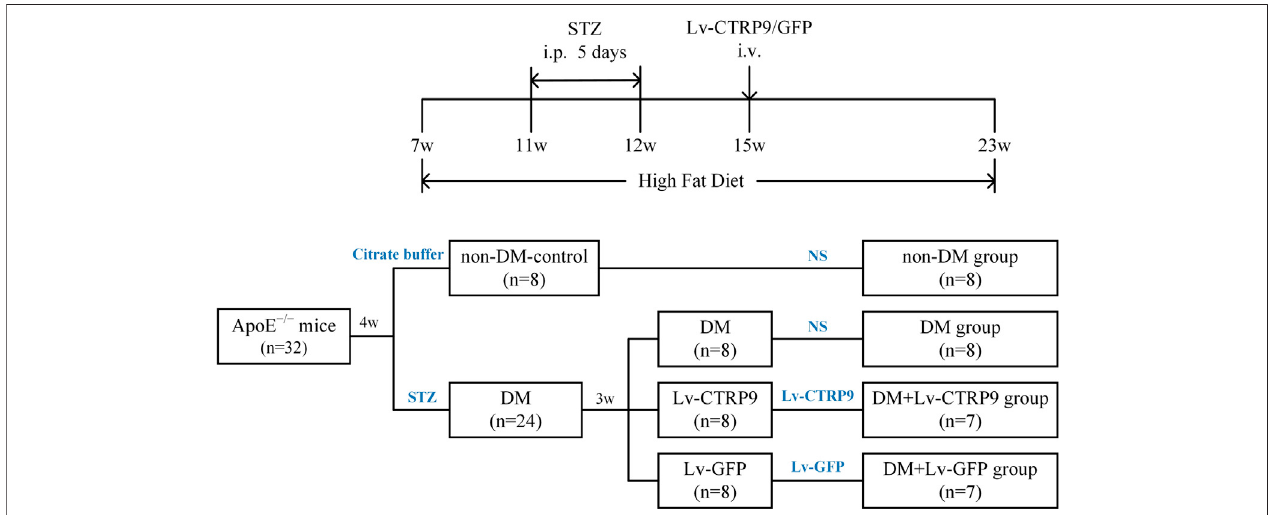
FIGURE 6 | Flow chart showing the animal groups and time lines of the experimental protocol in vivo . DM, diabetes mellitus; STZ, streptozotocin; Lv-CTRP9, lentiviruses-mediatedCTRP9overexpressing;Lv-GFP,lentiviruses-mediatedgreen fl uorescentprotein;NS,normalsaline;i.p.,intraperitonealinjection;i.v.,intravenous injection; w, week